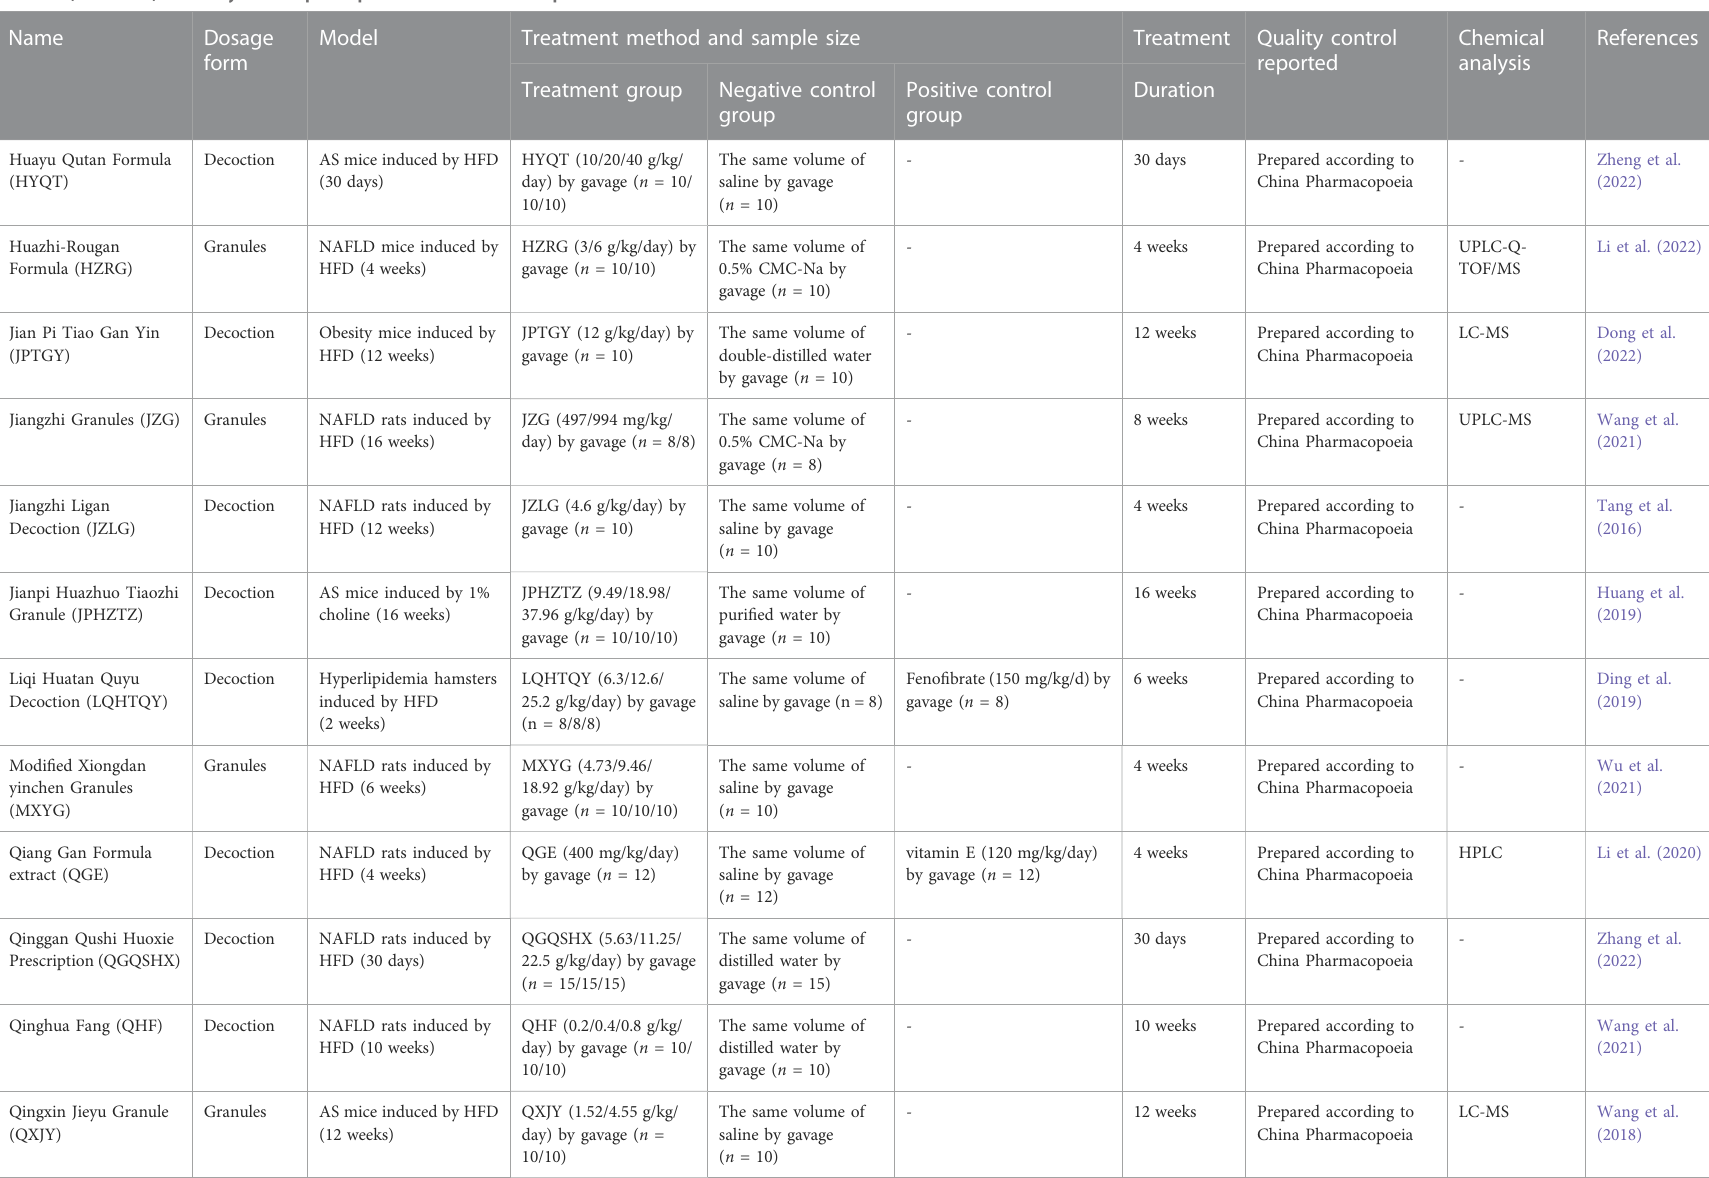
TABLE 3 ( Continued ) Summary of TCM prescriptions used in animal